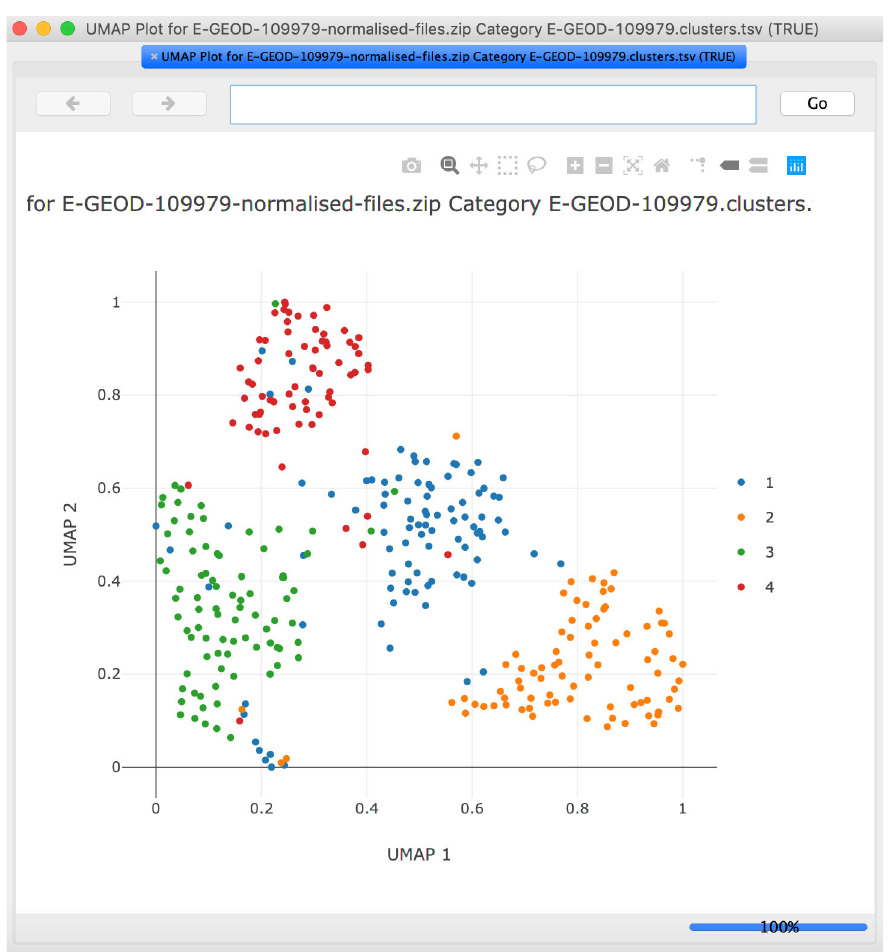
Figure 4. The UMAP plot is displayed in a pop-up window and can be explored interactively. Each dot is a cell, and coloring is by cluster number. Note that the illustration shows results obtained from analysis with the default